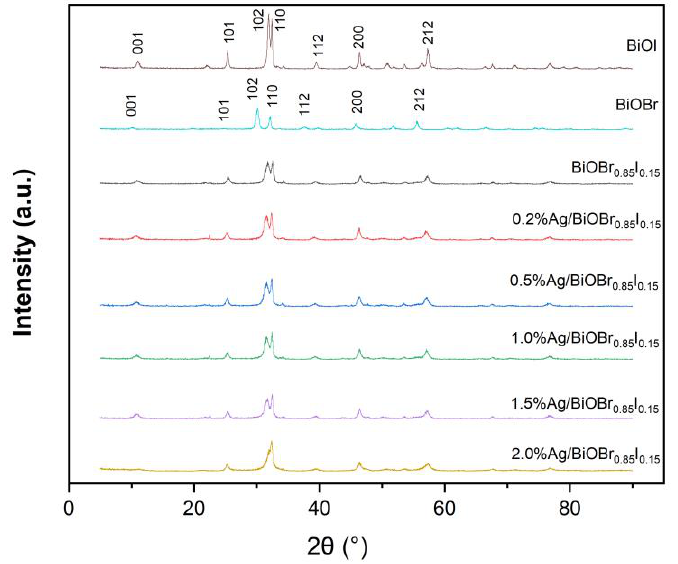
Figure 1. XRD patterns of BiOI, BiOBr, BiOBr 0.85 I 0.15 , and Ag/BiOBr 0.85 I 0.15 with different Ag